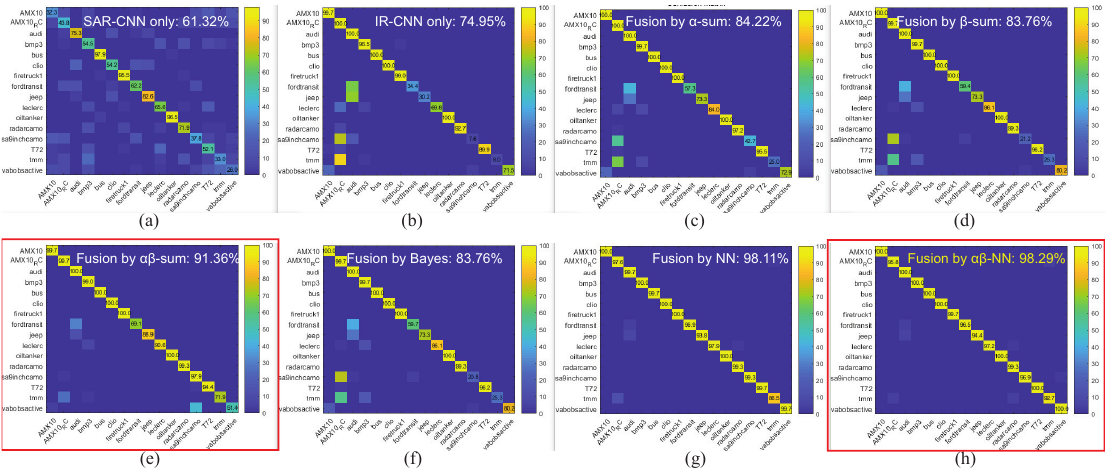
Figure 23. Confusion matrices at the translation level of 1.5 pixels: ( a ) SC; ( b ) IC; ( c ) α -sum; ( d ) β -sum; ( e ) αβ -sum (proposed linear fusion scheme I); ( f ) BF [57]; ( g ) NN; and ( h ) αβ -NN (proposed nonlinear fusion scheme II).